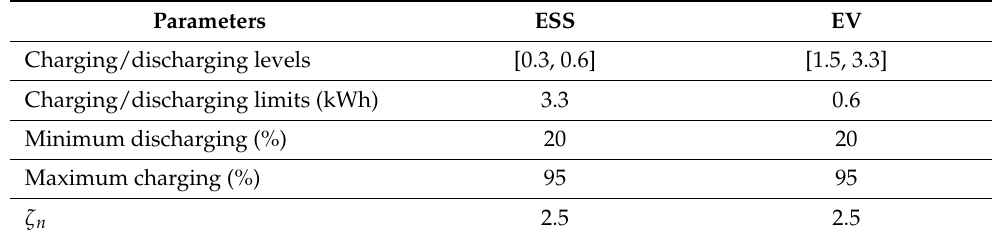
Table 4. Parameters of EV and ESS.